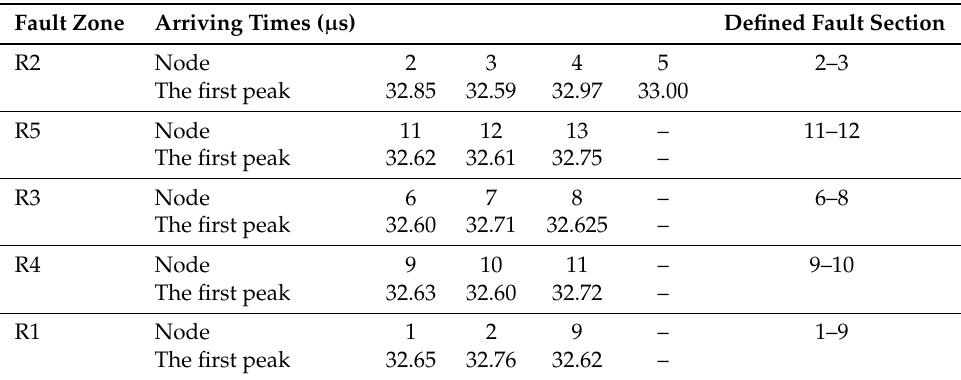
Table 5. Section